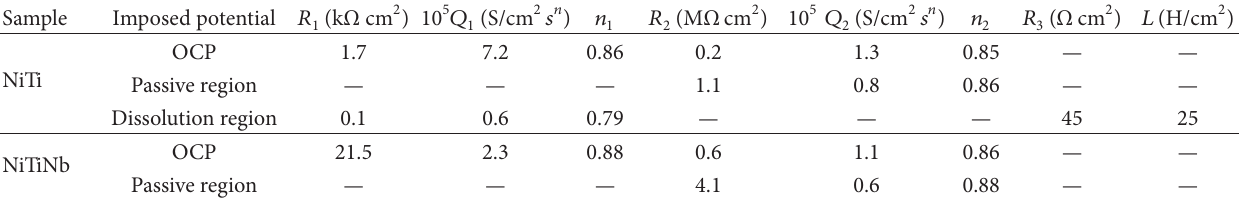
T 2: Impedance parameters of NiTi and NiTiNb alloys in physiological 0.9